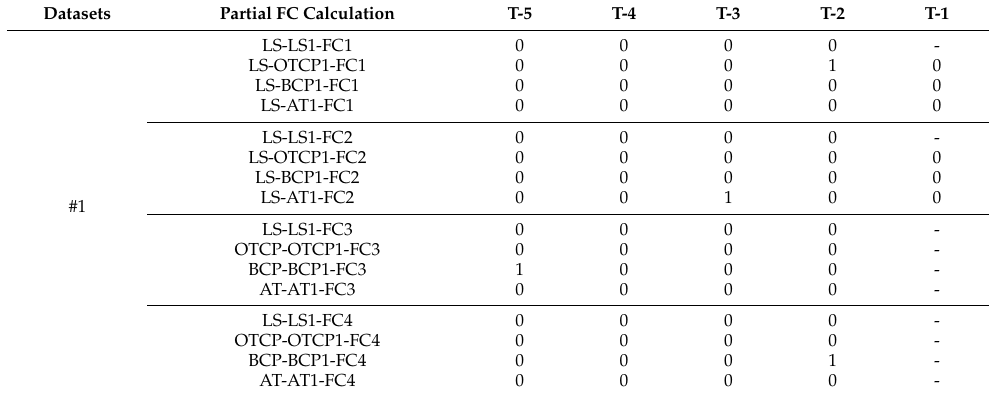
Table A1. Partial feature selection results of RL based on feature crossing frameworks for input